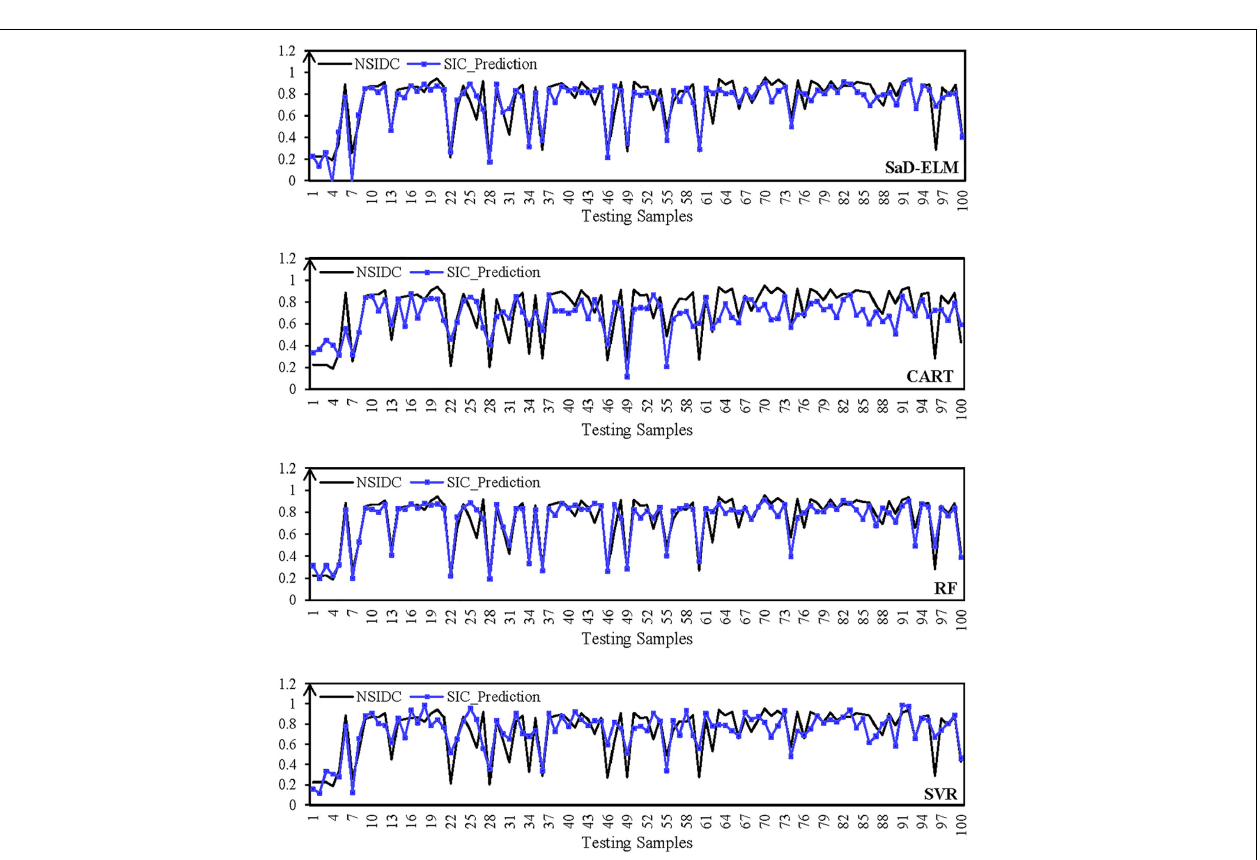
FIGURE 7 | Predicted SIC at grid point (80 ◦ E, 80 ◦ N) (the black line represents the observed SIC of NISIDC; the blue line represents the predicted SIC in lead time = 1 d).